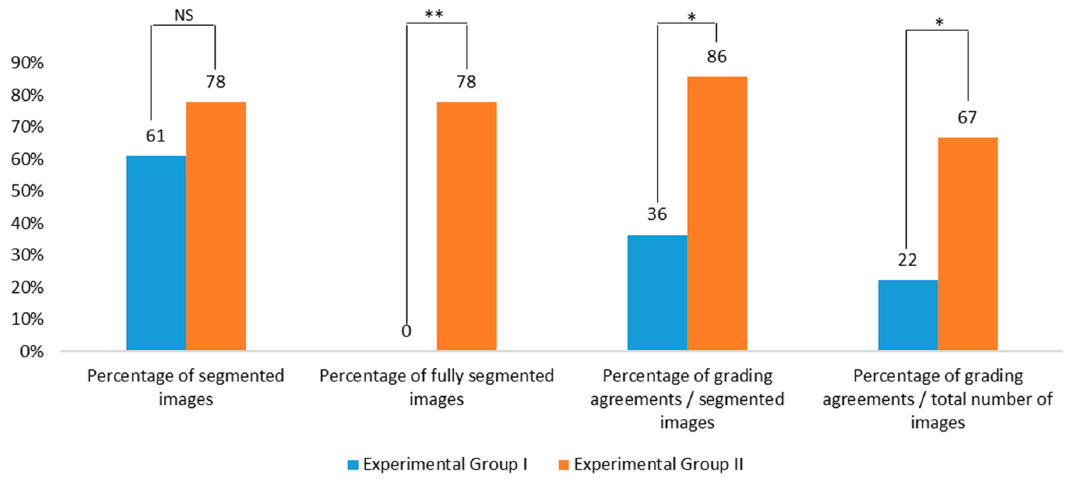
Figure 5. Results of segmentation and grading agreement (related to the grading image produced by control group) of experimental groups I and II (Dataset 1). Fisher Exact Test: NS: p = 0.471), ** p < 0.001, and * p < 0.02.